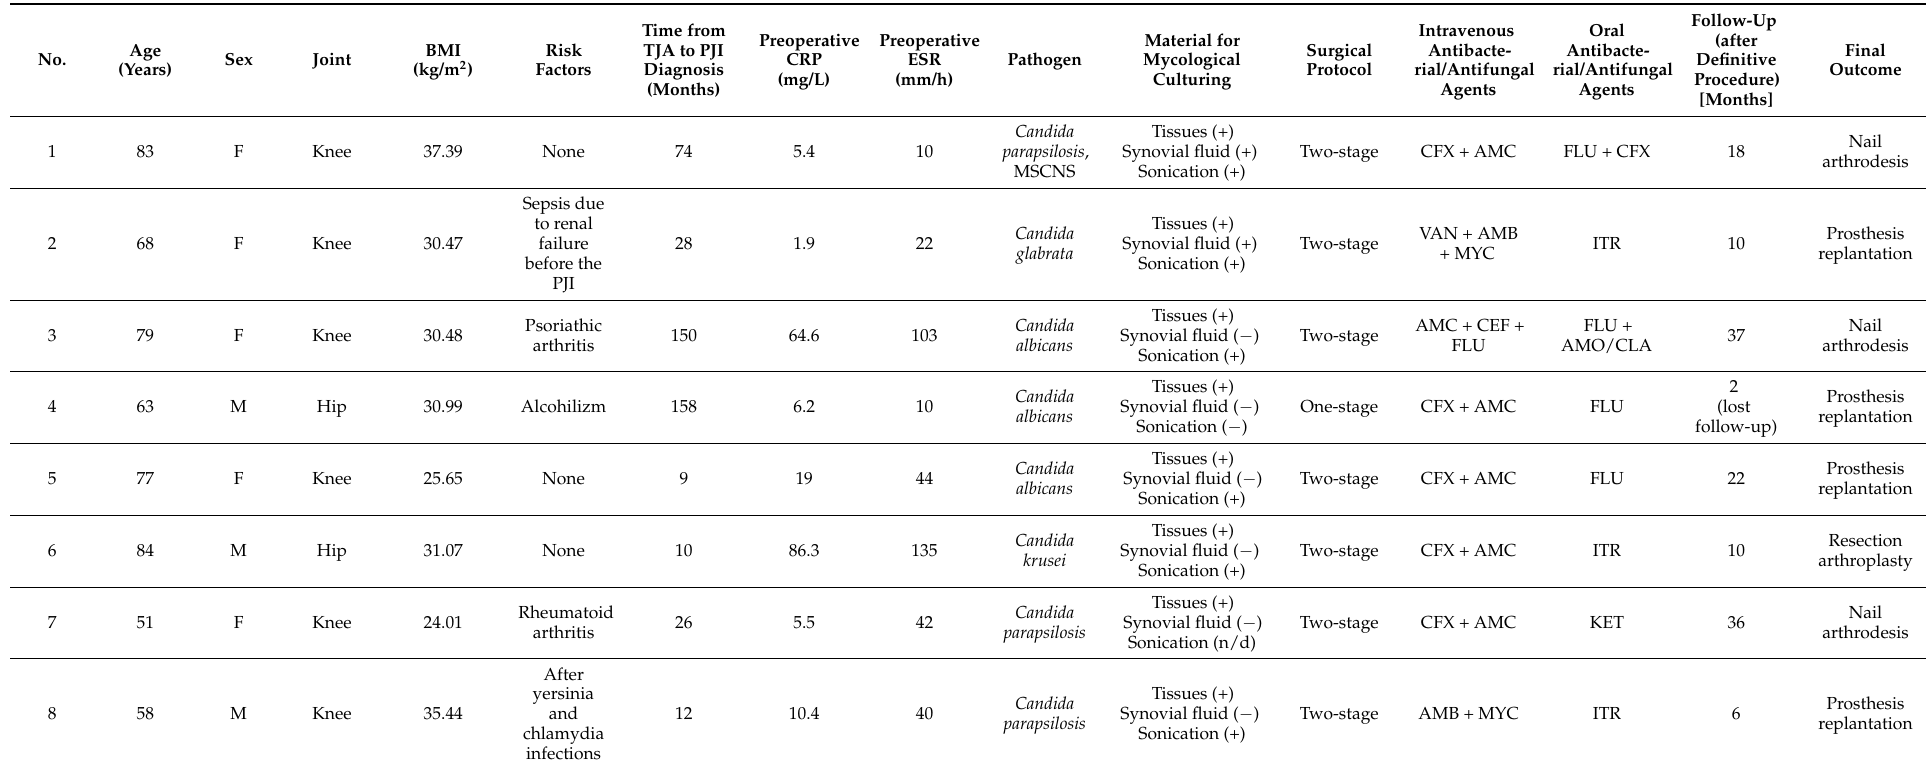
Table 1. Patients’ characteristics included in the